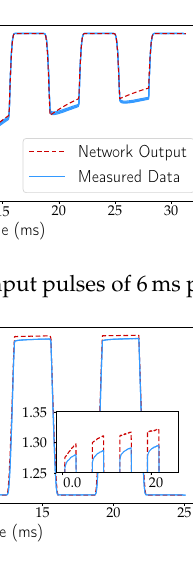
Figure 7. Expected dynamics of a a-IGZO memristor and the output of an MSNN network with externa input and [ 2,50,50,1 ] topology to both potentiation and depression inducing pulses. ( a ) Demonstration of depression with the output of the network versus a point-cloud of measured data. ( b ) Demonstration of potentiation with the output of the network versus a point-cloud of measured data. The inset graph showcases a zoomed in portion of image ( b ), pointing out the difference between network output and measured